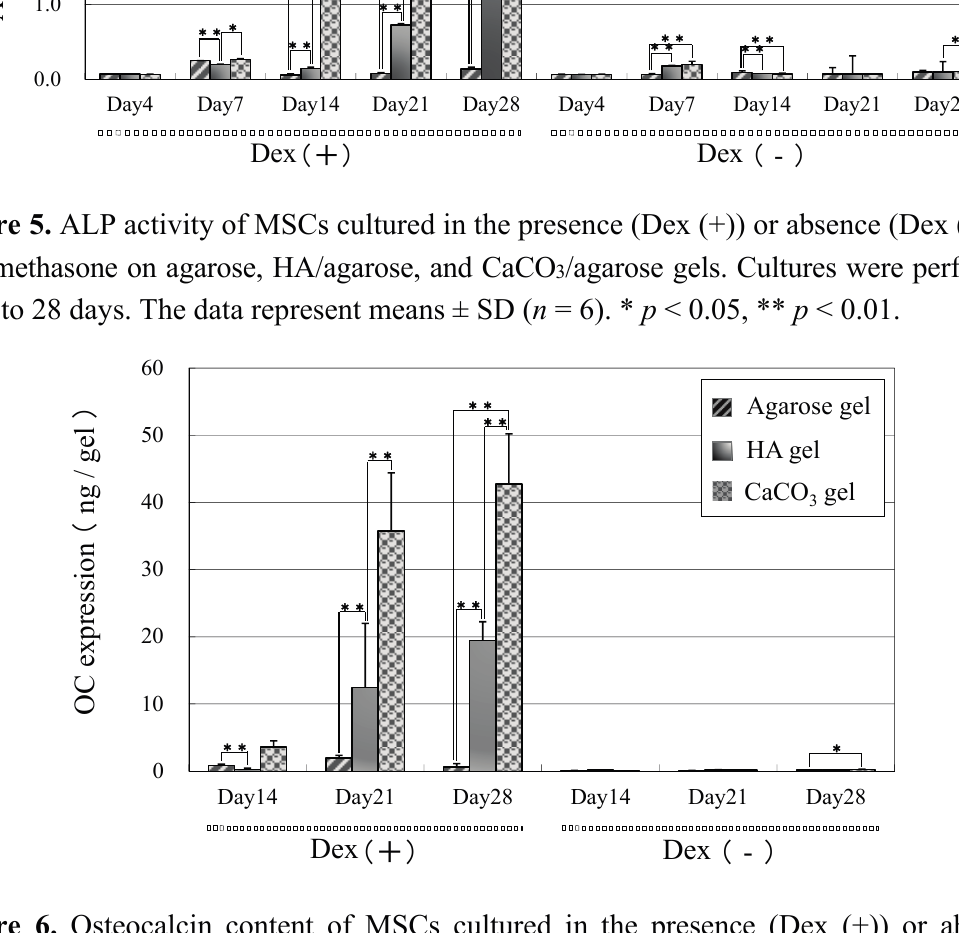
Figure 6. Osteocalcin content of MSCs cultured in the presence (Dex (+)) or absence (Dex ( − )) of dexamethasone on agarose, HA/agarose, and CaCO 3 /agarose gels. Cultures were performed for 4 to 28 days. The data represent means ± SD ( n = 6). * p < 0.05, ** p <